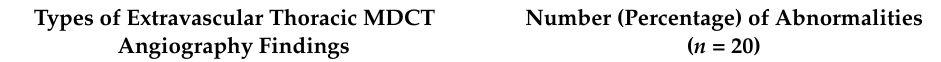
Table 1. Summary of Extravascular Thoracic MDCT Angiography Findings of Children with Sec- ondary PVS Due to TAPVC